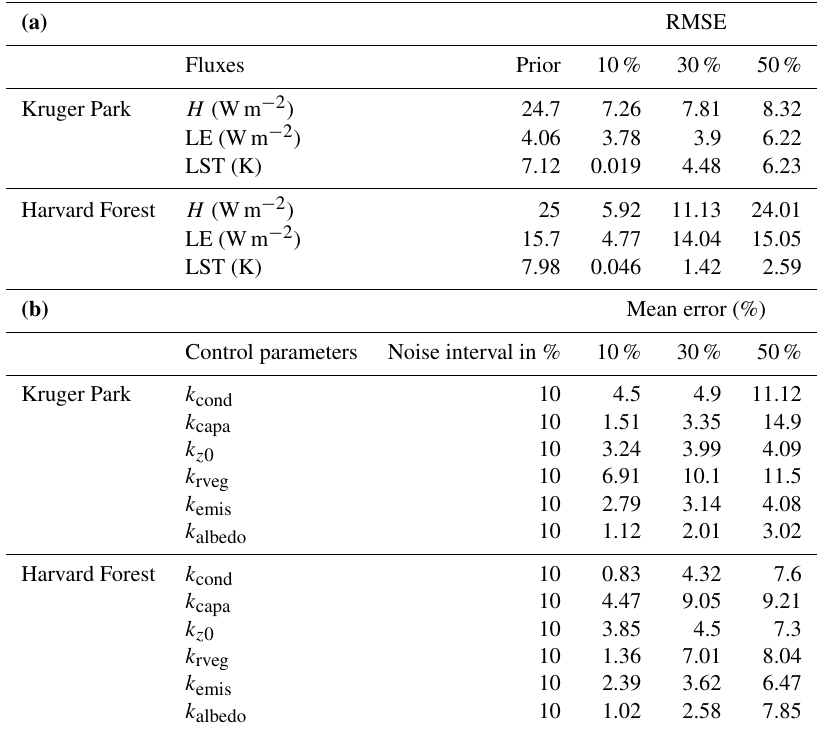
Table 7. Experiment 2 (different amplitudes of random noise in the observations) using the Harvard Forest and Kruger Park sites. We present the mean values for 500 experiments: (a) the first two columns give the computed fluxes prior to the assimilation. The last three columns present the RMSE (prior minus estimated) for a given level of noise added to the observations (10, 30, 50%). (b) The first two columns give the noise interval (in %) introduced for each control parameter with respect to the initial value of 1. The last three columns present the mean error in % in the control parameters for different levels of noise (10, 30, 50%) added to the observations (LST).